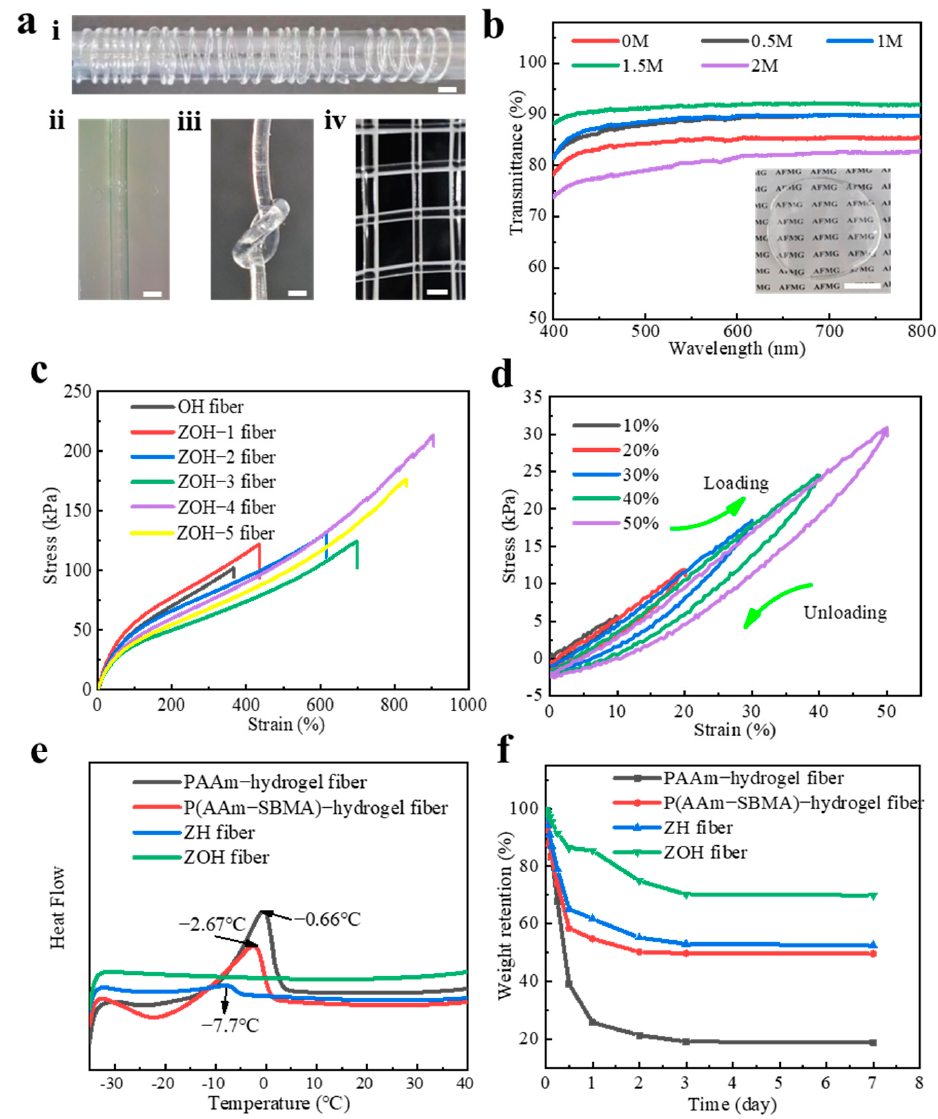
Figure 2. ( a )( i ) A representative photograph of a segment of the ZOH fiber. Scale bar: 1 cm. ( ii ) Image of the ZOH fiber under an super-depth-of-field microscope. Scale bar: 1 mm. ( iii ) Knotting ability of the ZOH fiber. Scale bar: 1 mm. ( iv ) A photo of the ZOH fiber forming a simple pattern. Scale bar: 2 mm. ( b ) Measured optical transparency of the ZOH fiber with different formulations in the spectral range of 400–800 nm. The illustration is a photo of a block of ZOH covering a pattern. Scale bar: 1 cm. ( c ) Tensile stress–strain curves for different SBMA contents. ( d ) Cyclic tensile stress–strain curves of the ZOH fiber with strains of 10%, 20%, 30%, 40%, and 50%. ( e ) The DSC curves of gels prepared with different formulations. ( f ) Long-term stability test of gels prepared with different